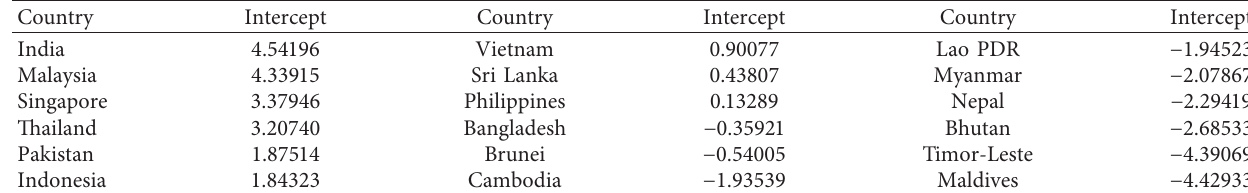
Table 5: The fixed-effect intercepts of each country in model IV.